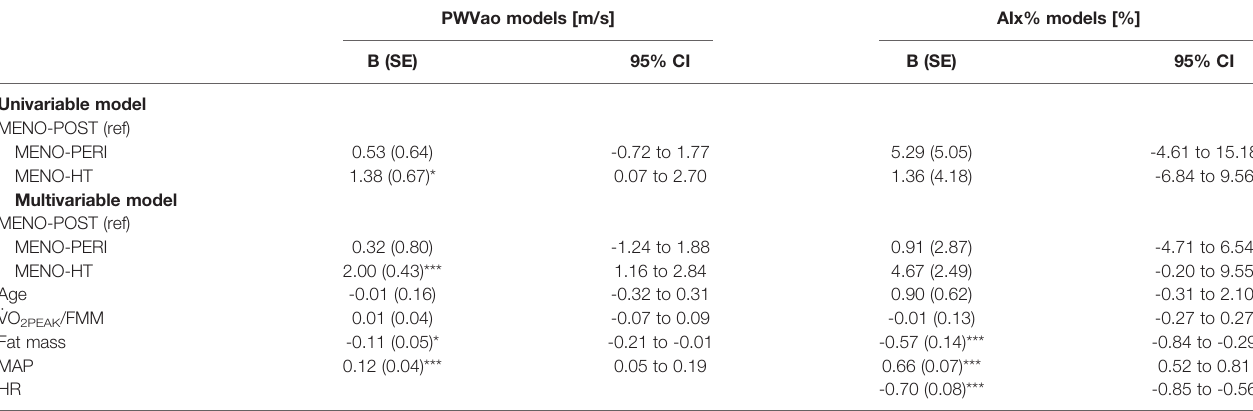
TABLE 7 | Association of menopausal stages with arterial